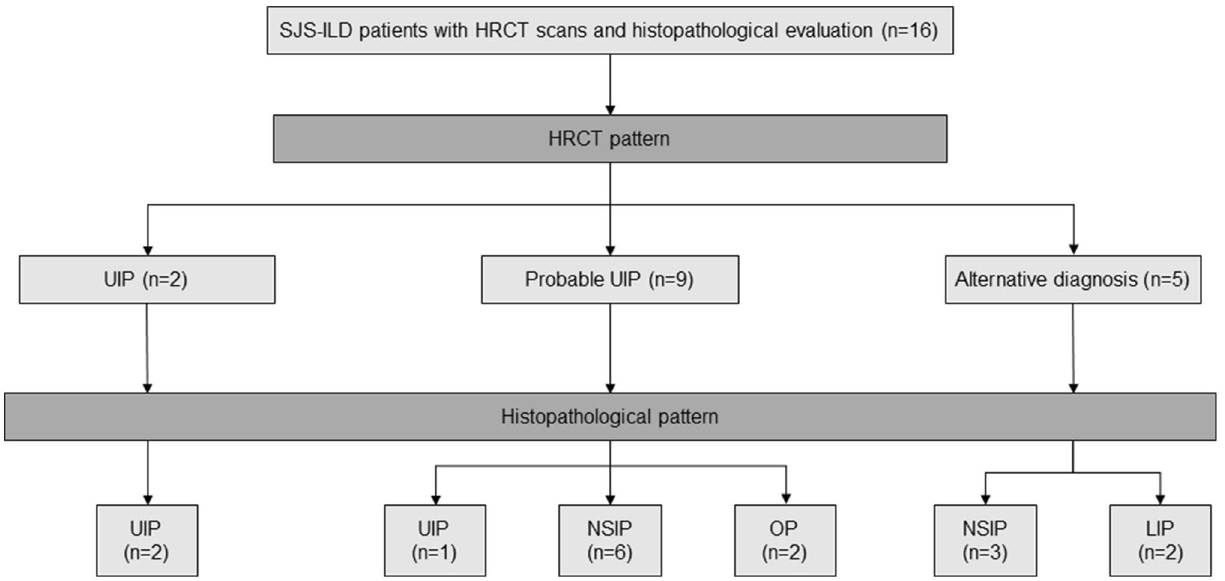
Figure 1. Flowchart of histopathology and HRCT pattern in patients with SJS-ILD. HRCT high-resolution computed tomography, ILD interstitial lung disease, LIP lymphocytic interstitial pneumonia, NSIP nonspecific interstitial pneumonia, OP organizing pneumonia, SJS Sjögren syndrome, UIP usual interstitial pneumonia.